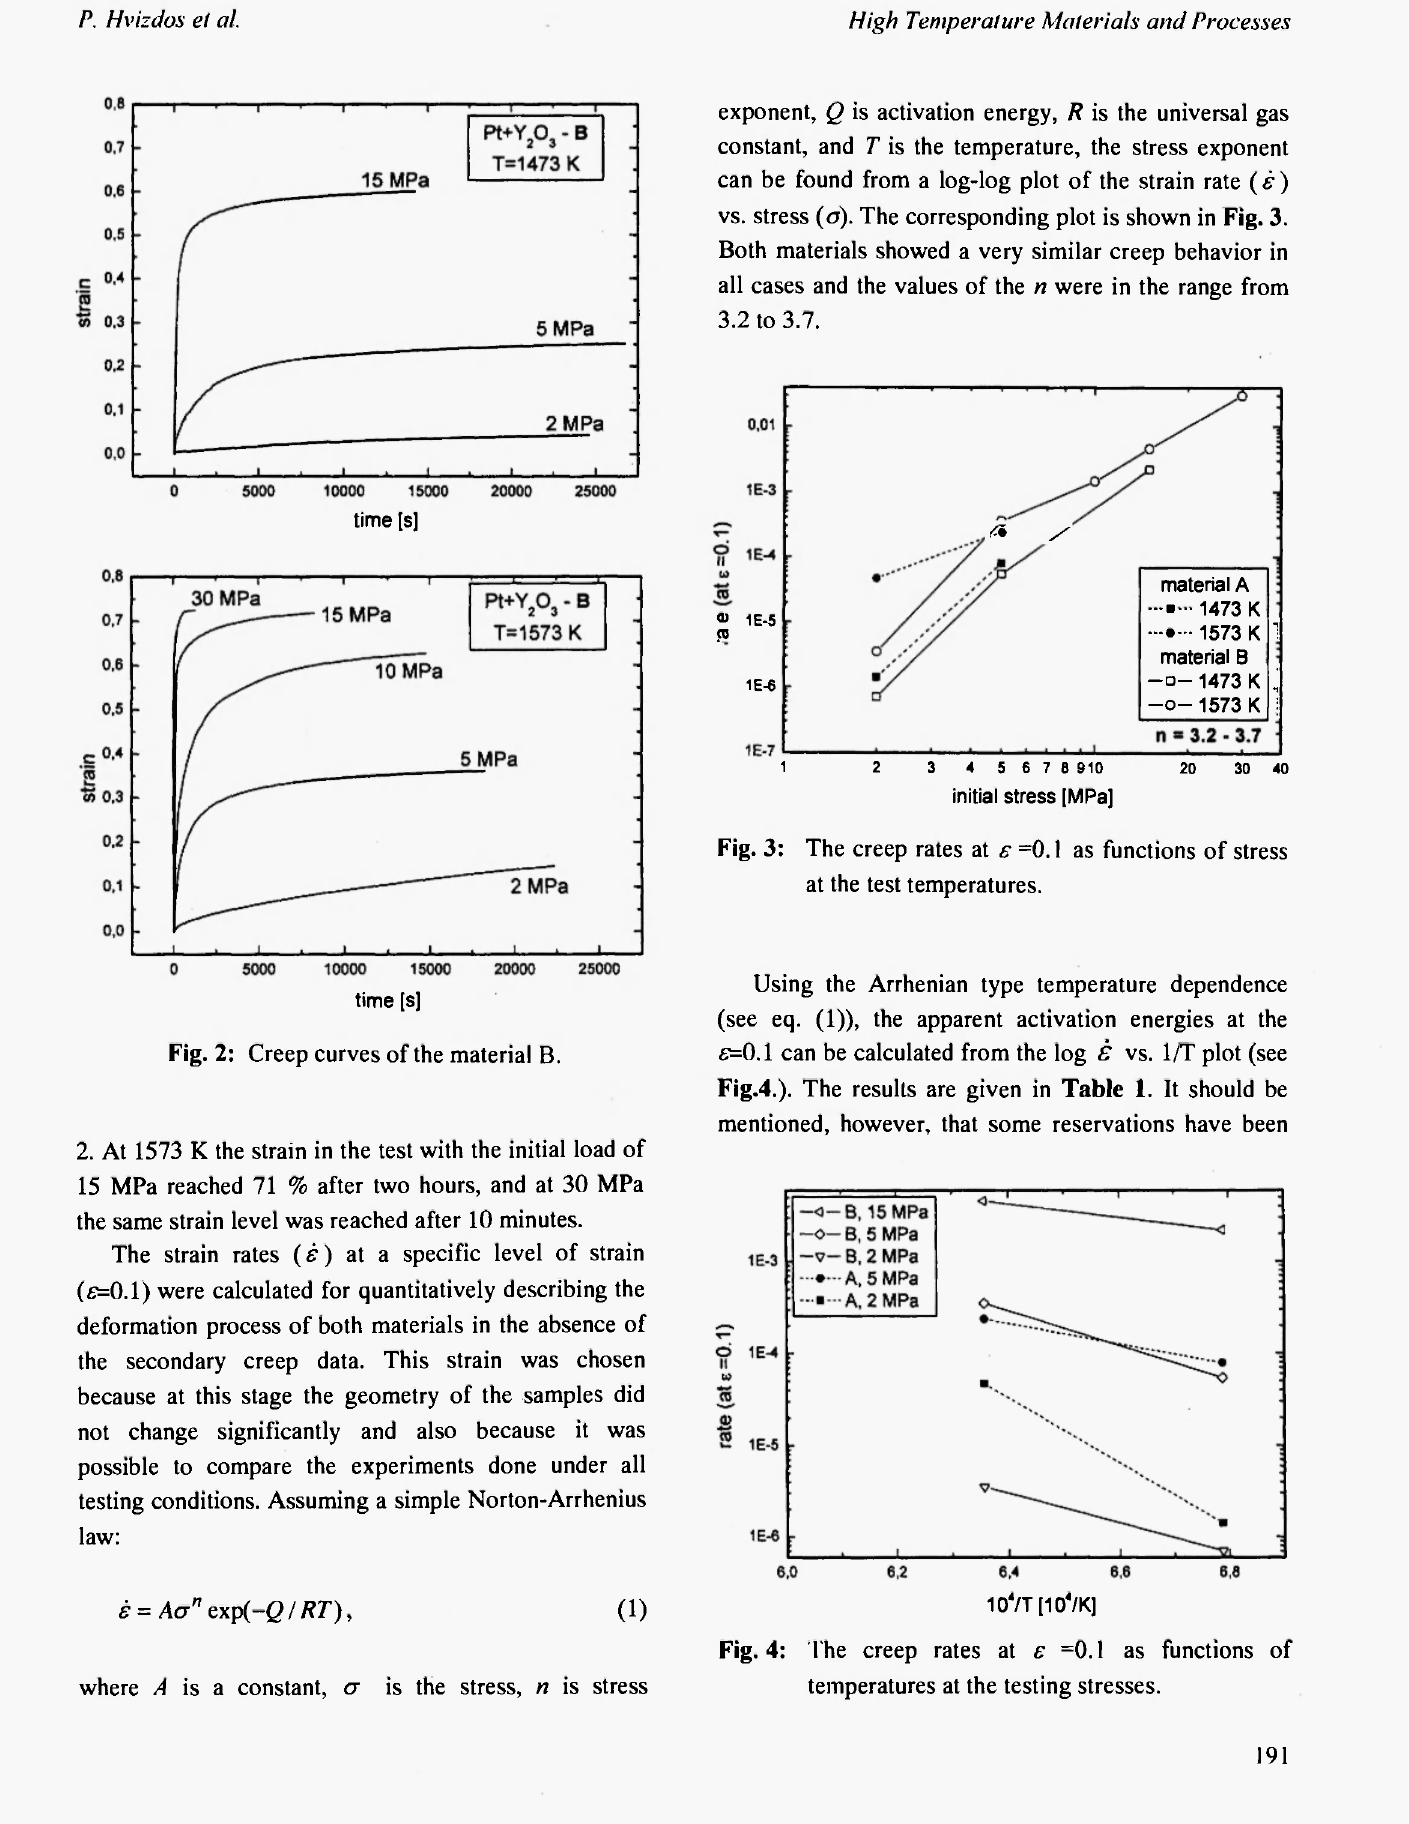
Fig.4: The creep rates at ε =0.1 as functions of temperatures at the testing